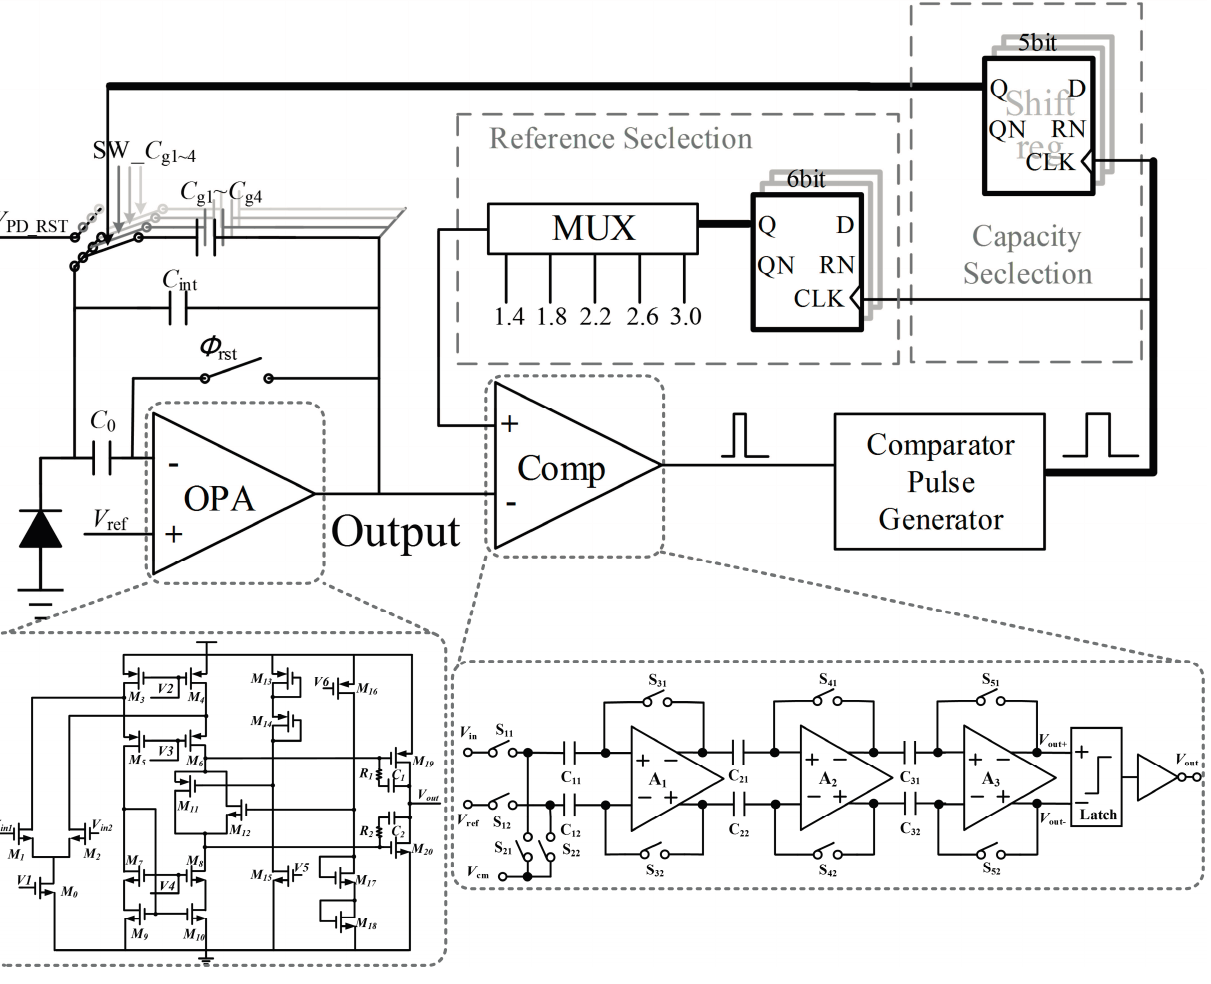
Figure 4. Circuit diagram of